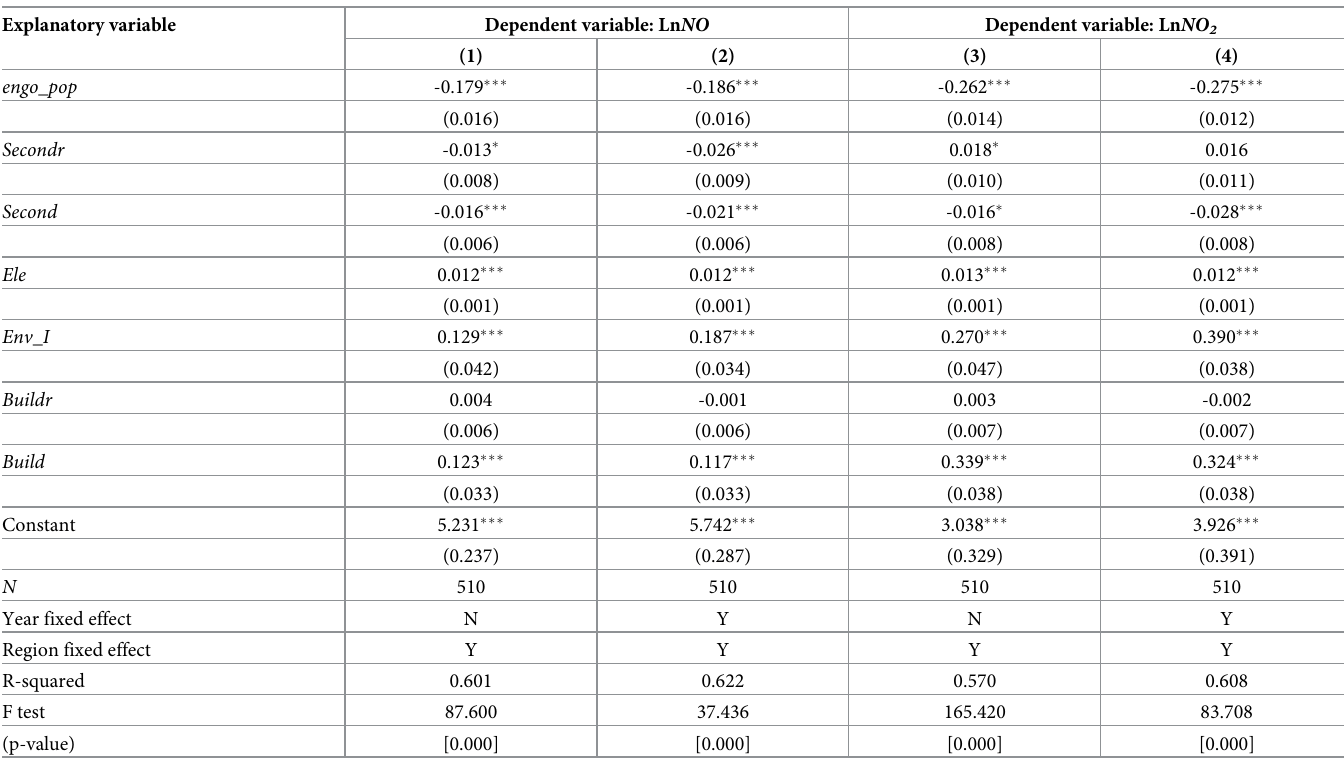
Table 4. Oxynitride emission reduction effect of ENGOs. Explanatory